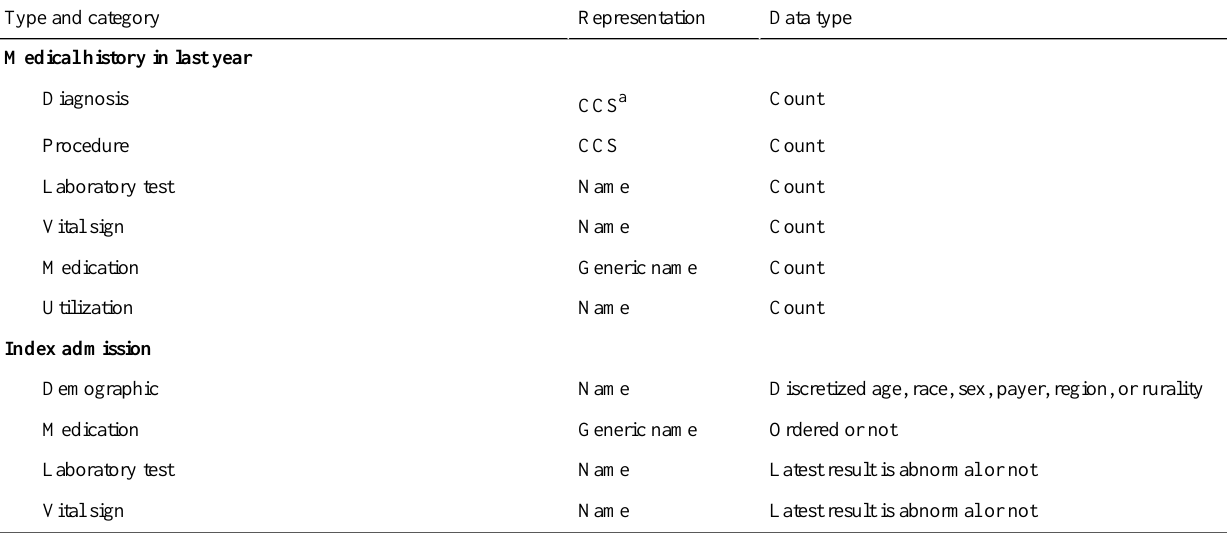
Table 1. Feature representation and value